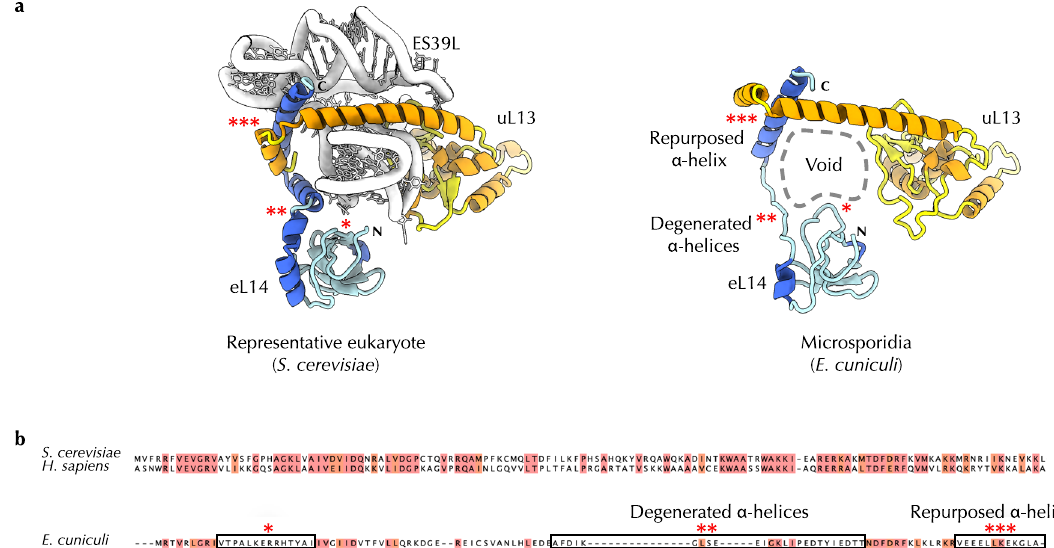
Fig. 7 Hypervariable sequences can render microsporidian proteins undetectable for homology searches. a Microsporidian ribosomes have lost the rRNA expansion ES39L, which partially eliminated the binding site for ribosomal protein eL14. In the absence of ES39L, microsporidian protein eL14 underwent a loss of secondary structure, in which former rRNA-binding α -helices degenerated to minimal-length loops. b Multiple sequence alignment shows that protein eL14 is highly conserved among eukaryotic species (where it shares 57% sequence identity between yeast and human homologs), but poorly conserved and divergent among microsporidia (where no more than 24% of residues are identical to eL14 homologs from S. cerevisiae or H. sapiens ). This poor sequence conservation, along with changes in the secondary structure, explains why homologs of eL14 have never been found in E. cuniculi and why this protein was thought to have been lost in E. cuniculi . Instead, E. cuniculi eL14 was previously annotated as the hypothetical protein M970_061160. This observation reveals that the diversity of microsporidian genomes is currently overestimated: some genes that are currently thought to have been lost in microsporidia are actually retained, although in a highly diverged form; conversely, some genes that are thought to encode microsporidia-speci fi c proteins (e.g., hypothetical protein M970_061160) do in fact encode highly divergent proteins that can be found in other